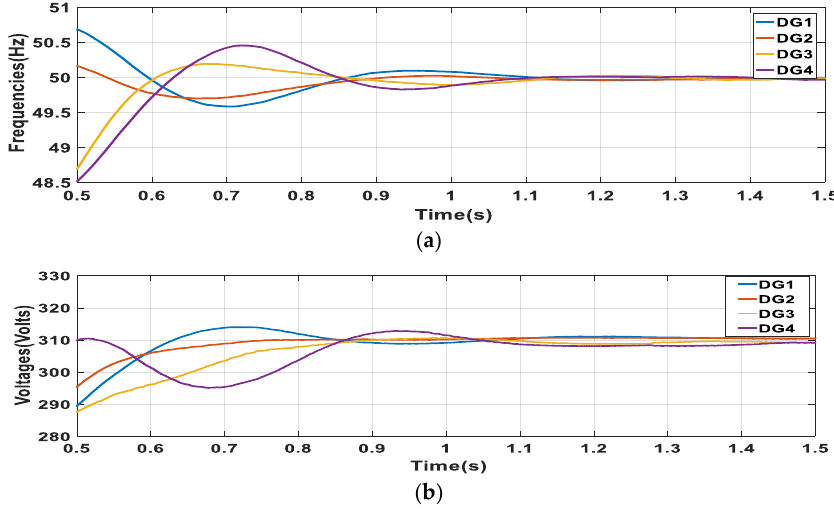
Figure 10. Outputs of 4 DGs: ( a ) frequency and ( b ) voltage restoration for group 1.